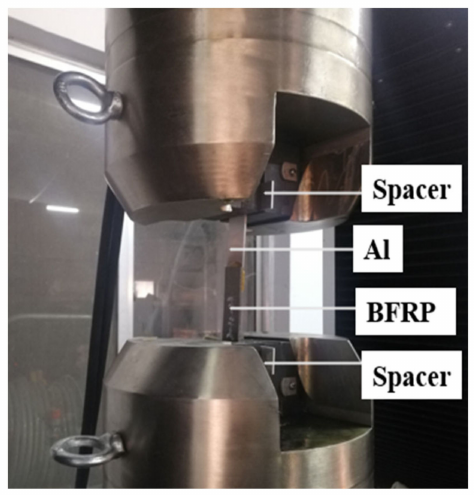
Figure 5. Quasi-static state tensile test